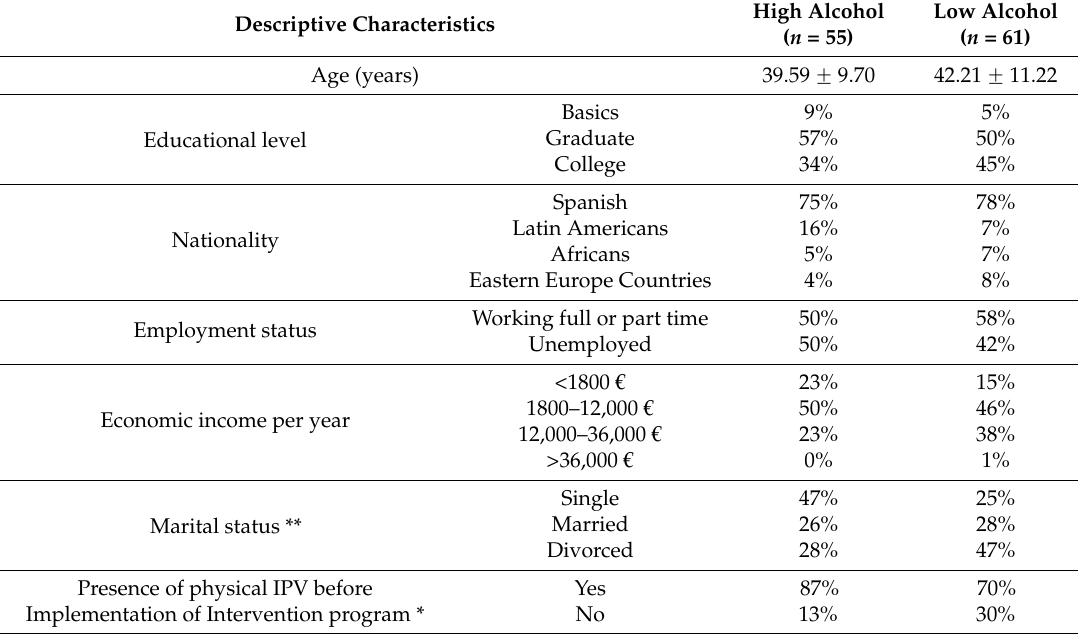
Table 1. Mean + SD of descriptive characteristics, psychological trait profiles and neuropsychological variables for High Alcohol (HA) and Low Alcohol (LA) IPV